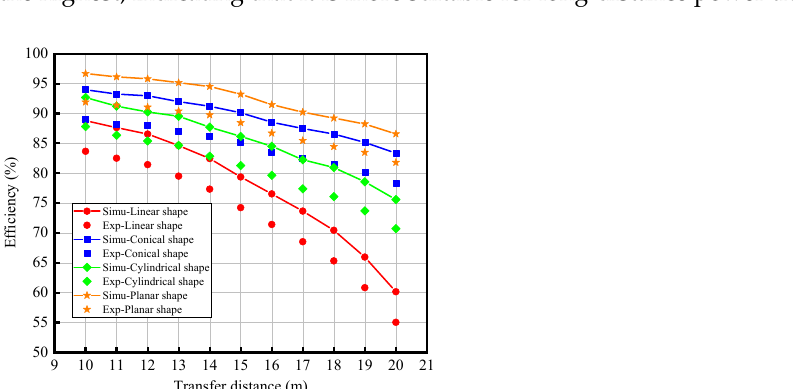
transfer structures at different distances.